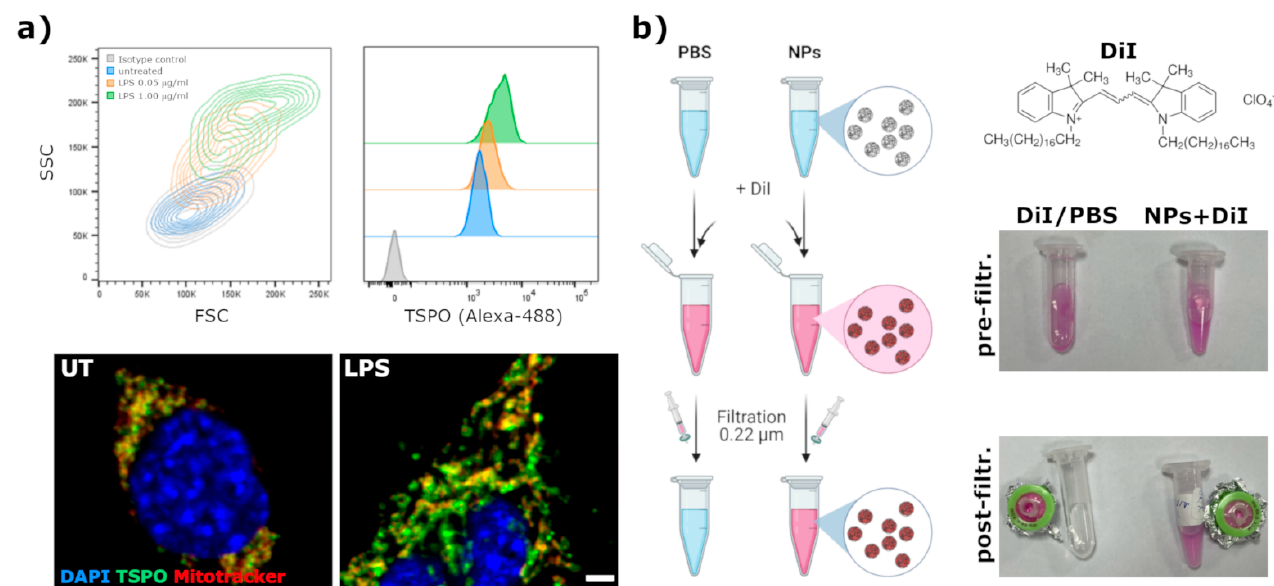
Figure 5. ( a ) Flow-cytometric and confocal fluorescence microscopy evaluation of TSPO expression and distribution in BV2 cells treated, or not, with LPS for 24 h. Scale bar = 2.5 μ m; ( b ) Labeling procedure of NPs with the lipophilic dye DiI.